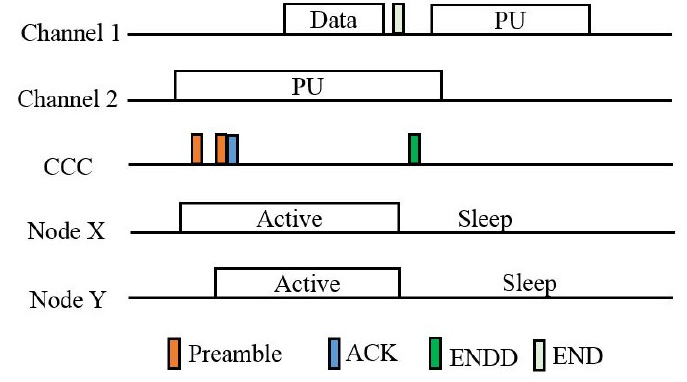
Figure 8. Timing diagram of the CR-WSN MAC protocol. ENDD, end of Figure 8 . Timing diagram of the CR-WSN MAC protocol. ENDD, end of data. Figure 8 . Timing diagram of the CR-WSN MAC protocol. ENDD, end of data.